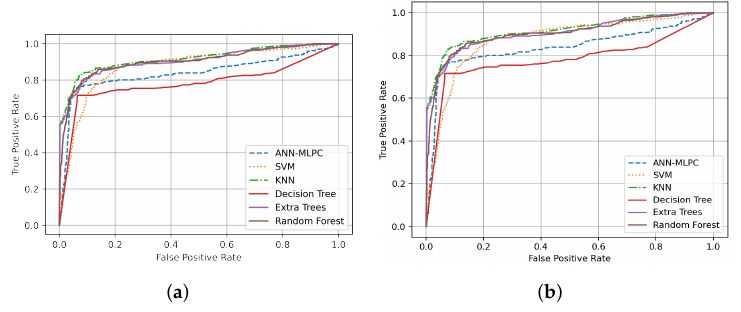
Figure 3. ROC curves. ( a ) ROC curve on PC, and ( b ) ROC curve on Raspberry Pi 4.